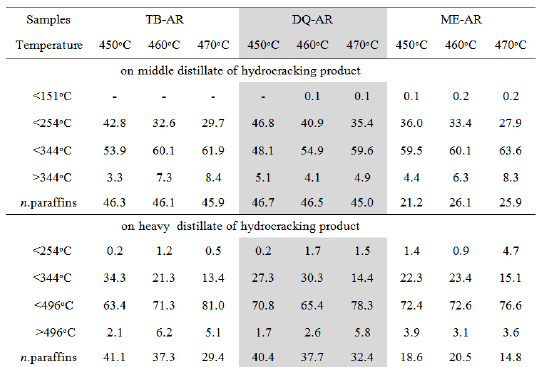
Table 4. Content of fractions and n-paraffins, in hydrocracking products, analyzed by GC-FID